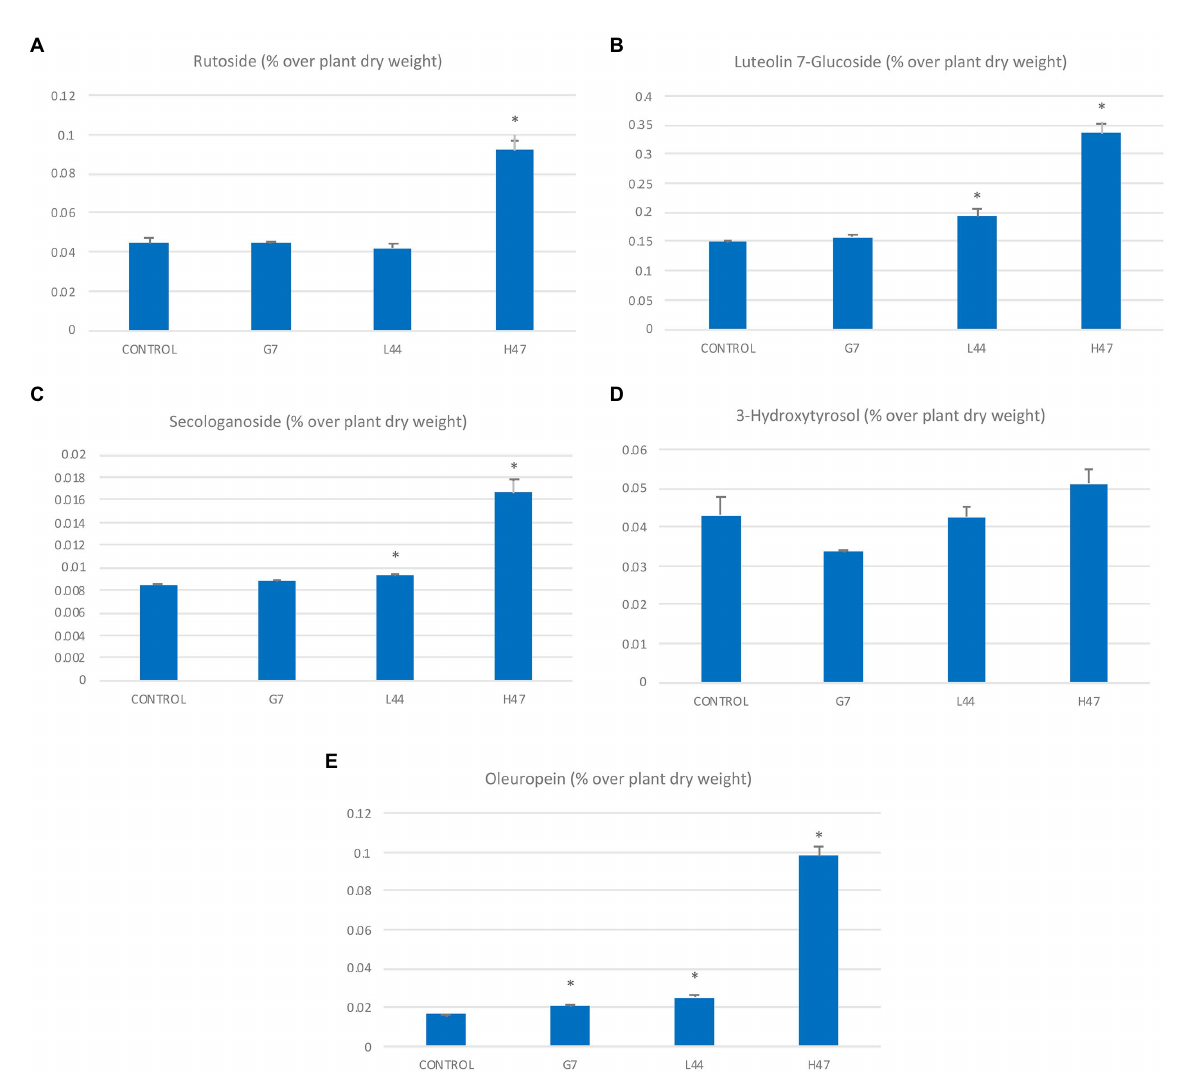
FIGURE 5 Polyphenol concentration ( μ g/g DW) in olive leaves from plants treated with the three strains and non-inoculated controls. Flavonols (A) Rutoside ( μ g/g); (B) Luteolin 7-glucoside; iridoids (C) Secologanoside ( μ g/g); (D) 3-hydroxytirosol ( μ g/g); and (E) Oleuropein ( μ g/g). For each treatment and parameter average value ± SE value is presented ( n = 6). Asterisks ( * ) represent significant differences with the control according to the T student test ( p <